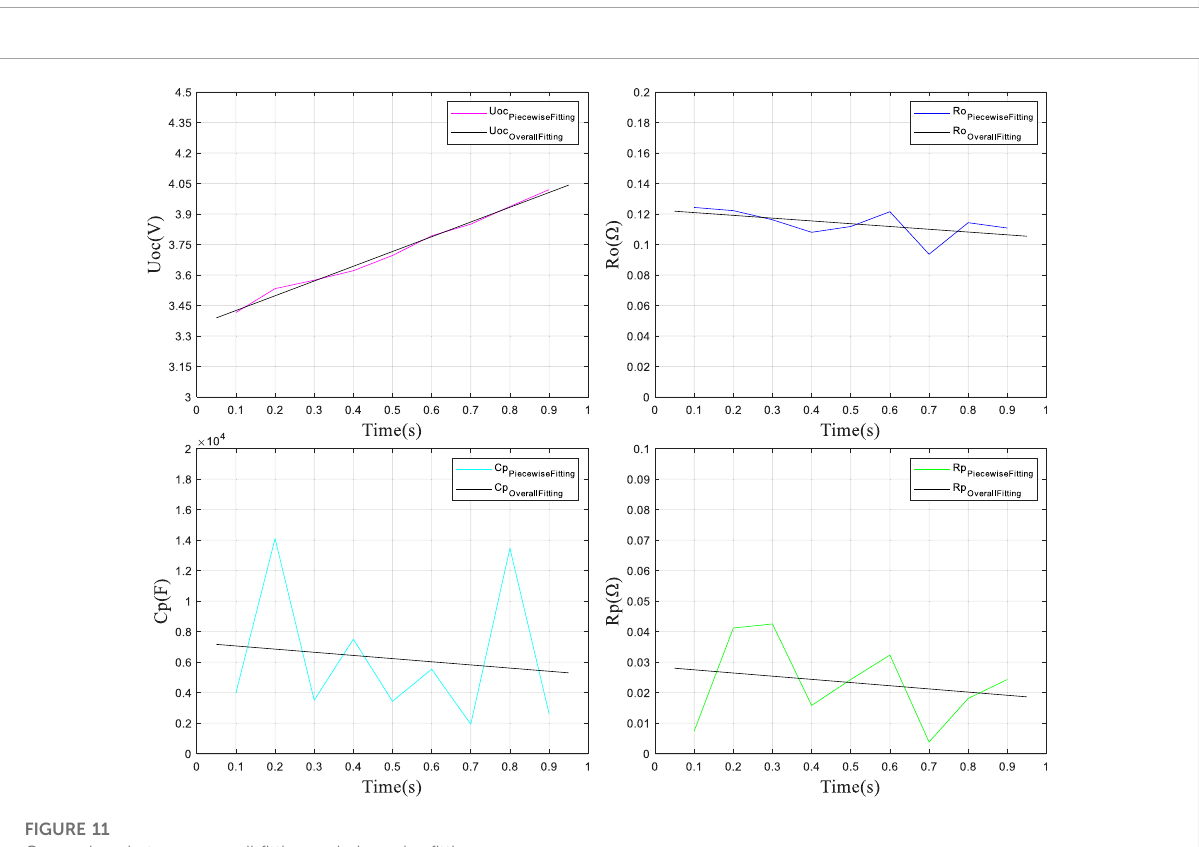
FIGURE 11 Comparison between overall fi tting and piecewise fi